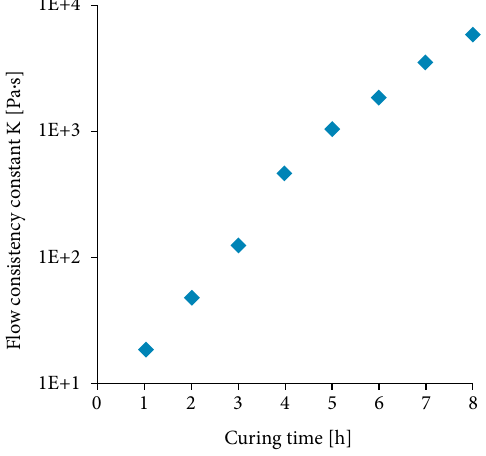
Figure 4. Variation in flow consistency constant of the liner with curing time.